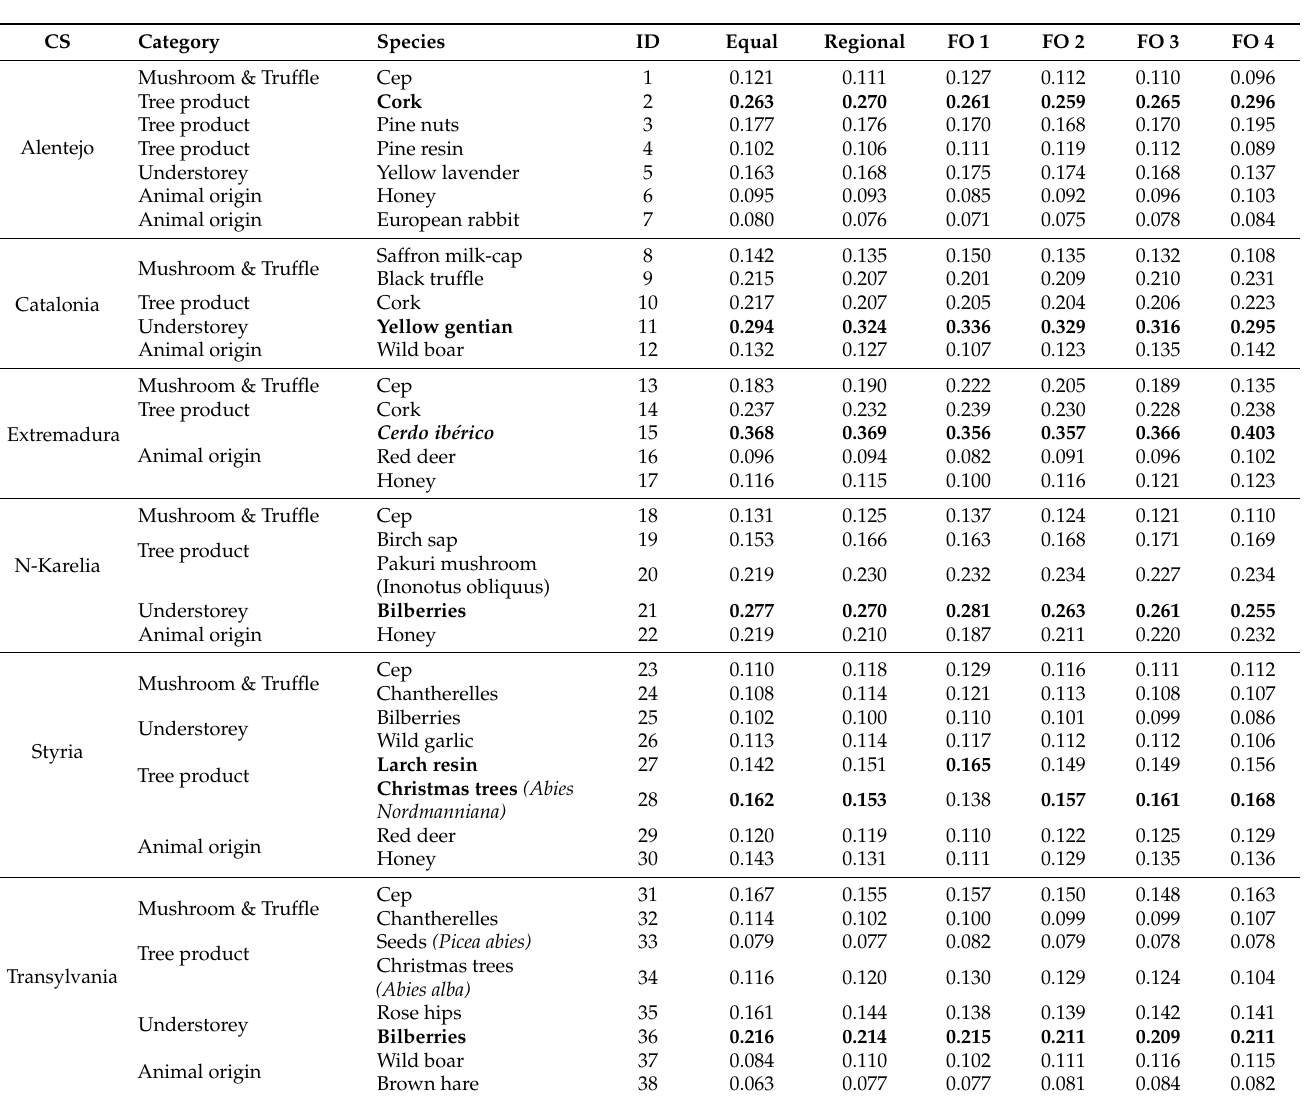
Table 5. Performance (i.e., global priorities) of NWFPs in the case studies per weighting scenario, high- lighting the most promising NWFP in bold letters (equal = equal weights for criteria and sub-criteria; regional = regional weights from Table 4 and equal weights for sub-criteria; FO 1–FO 4 = regional weights for criteria and the sub-criteria weights according to forest owner potential from Table